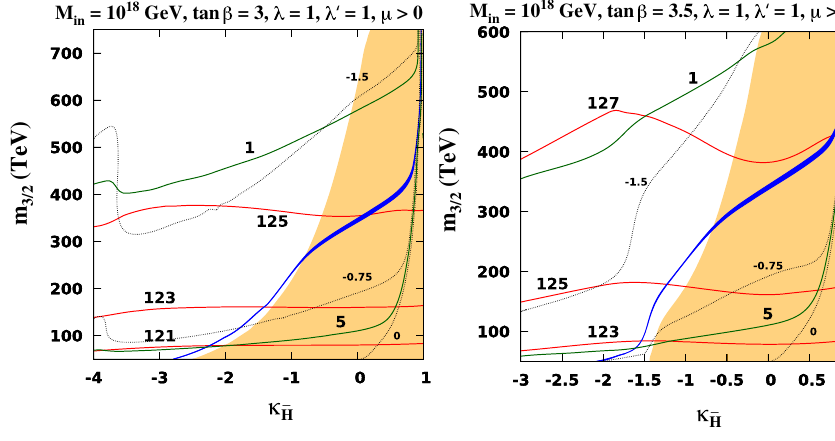
Fig. 11 Examples of κ ¯ - m 3 / 2 H planes for κ (cid:6) = κ H = 0, sign (μ) > 0, a tan β = 3, and b tan β = 3 . 5 with M in = 10 18 GeV, and λ = λ (cid:7) = 1. The red and green solid contours correspond to the Higgs mass m h and the proton lifetime τ( p → π 0 e + ) in units of GeV and 10 35 years, respectively. The blue shaded region shows the areas where the LSP abundance agrees to the observed dark matter density. The black dotted lines show the value of c . The orange regions is for a wino LSP and the white has a bino